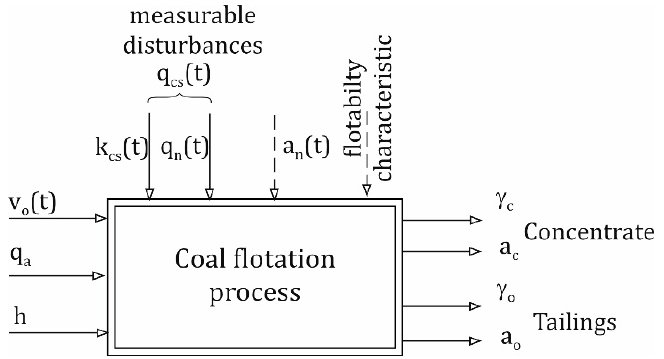
Figure 1. Coal flotation process as a facility with multiple inputs and multiple outputs.